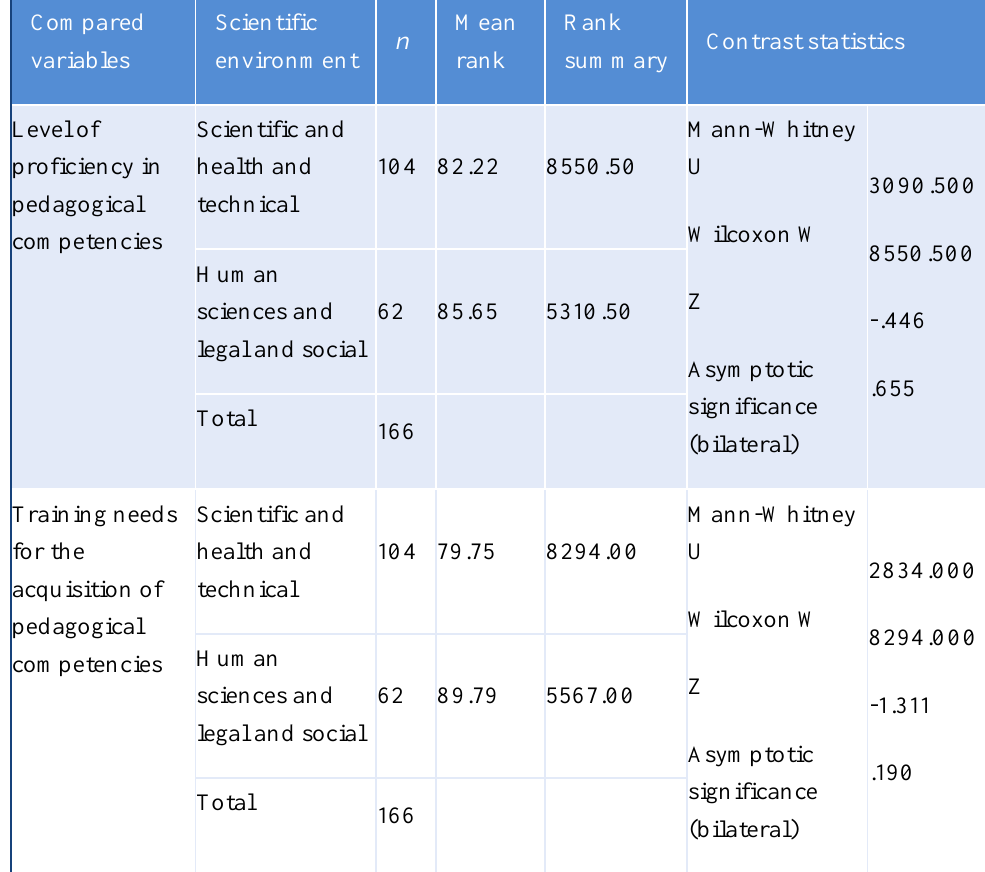
Table 7 Mann-Whitney Test (“Scientific Environment” Variable)